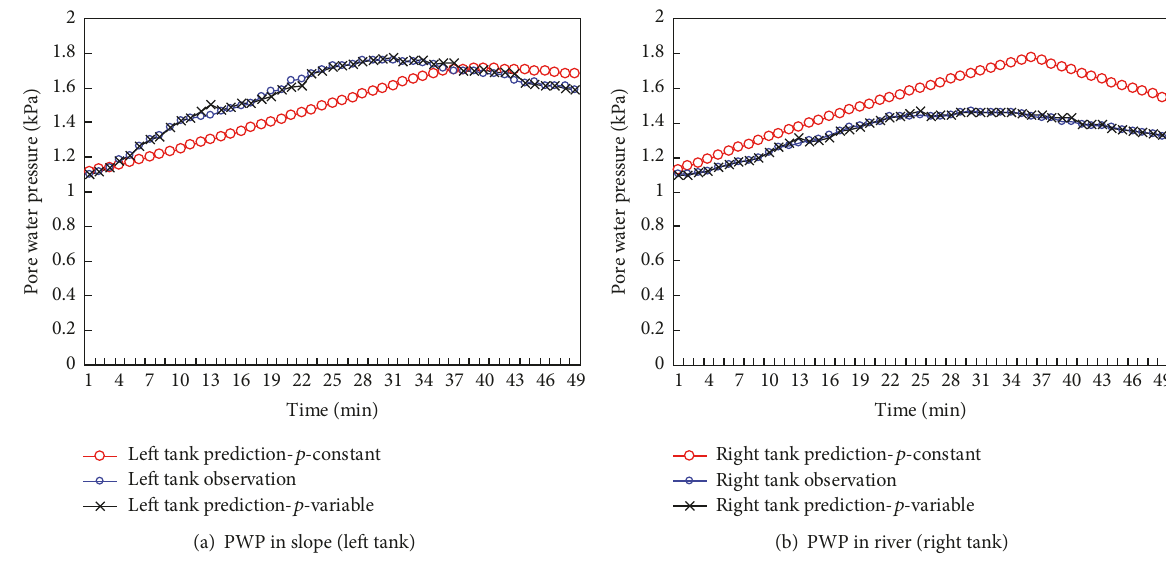
Figure 7: A comparison of nonincremental and incremental learning algorithms: (a) PWP in slope and (b) PWP in river.